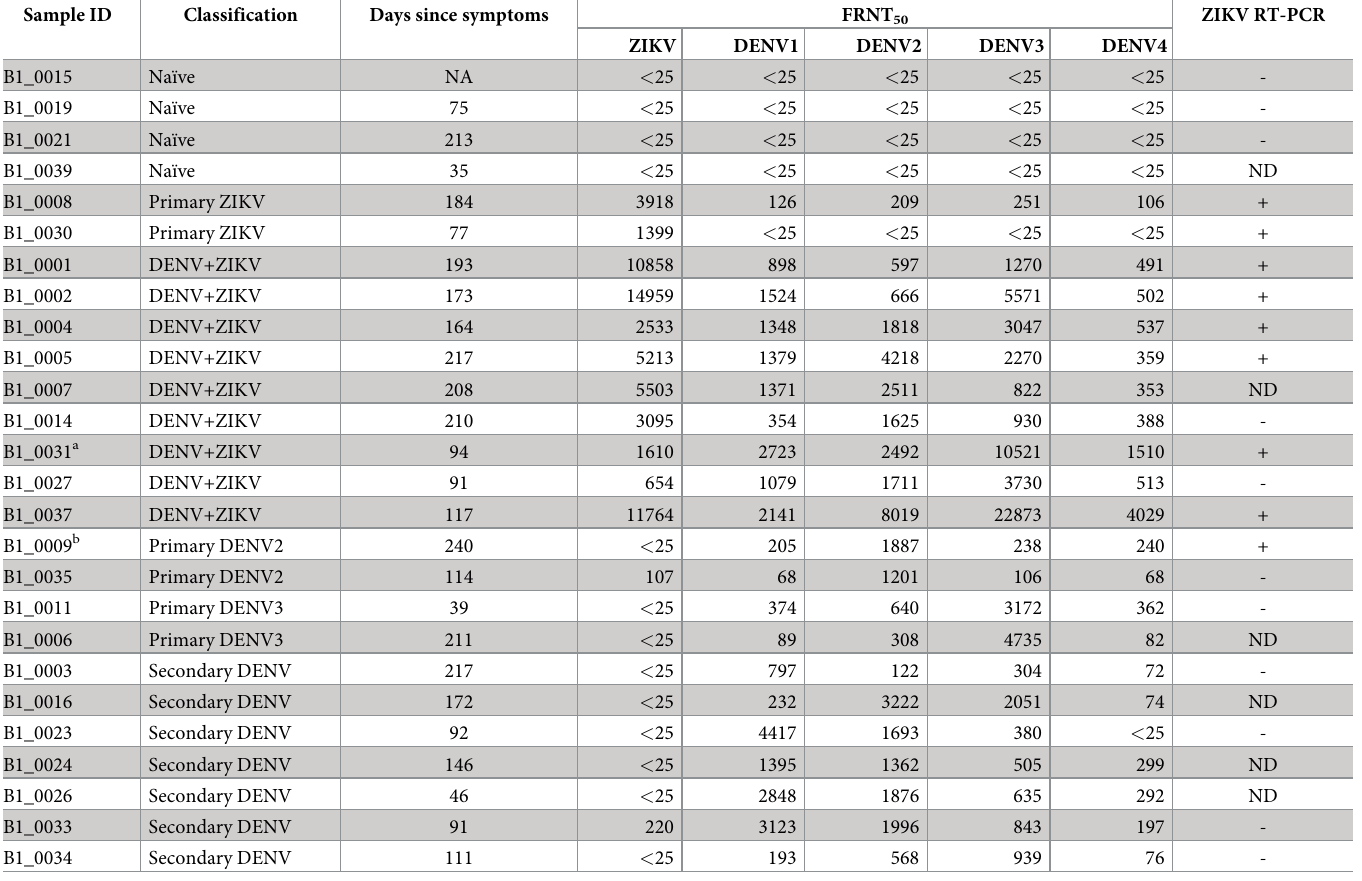
Table 2. ZIKV and DENV serotype specific humoral immune profile. Serologic classification of maternal flavivirus infection history was determined by focus reduction neutralization titer 50% (FRNT-50) against ZIKV and DENV in plasma taken at delivery. Sample